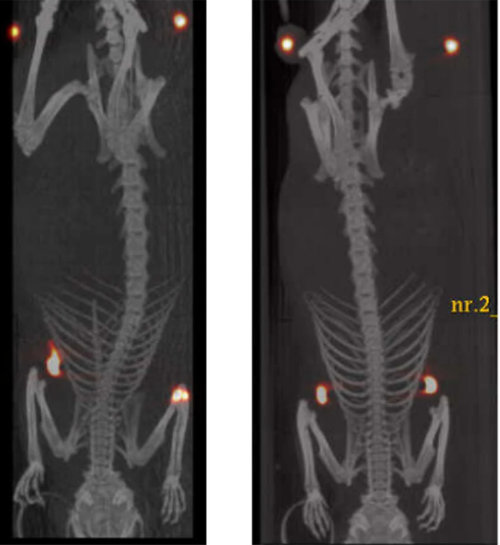
Figure 4. µPet/CT superimposed images of two adult female rats, 40 h after the injec- Figure 4. µ Pet/CT superimposed images of two adult female rats, 40h after the injection of 64 Cu- tion of 64 Cu-HAC in the mammary glands. In the upper part of the images, near hind HAC in the mammary glands. In the upper part of the images, near hind legs, two objects with high legs, two objects with high density and imbibed with 64 Cu are located as reference density and imbibed with 64 Cu are located as reference points for accurate overlapping of PET points for accurate overlapping of PET and CT images. Reproduced from [28] under a